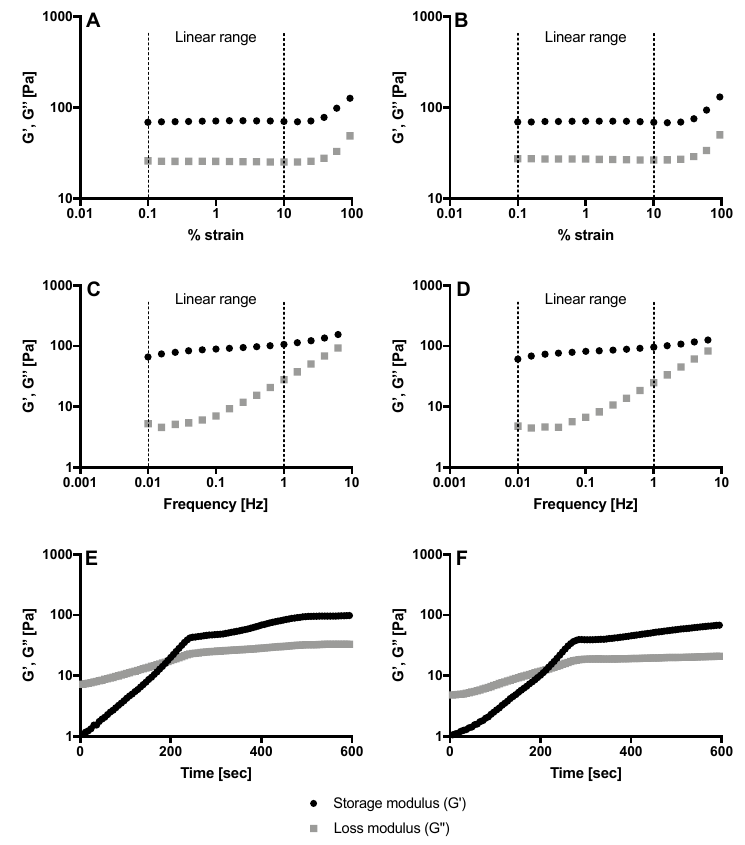
Figure 1. Rheological characterization of the synthesized methylcellulose hydrogels. ( A , B ) Strain sweep for 10% ( w / v ) methylcellulose hydrogel with 1% ( v / v ) Melissa o ffi cinalis ( A ) and 2% ( v / v ) Melissa o ffi cinalis ( B ). ( C , D ) Frequency sweep for 10% ( w / v ) methylcellulose hydrogel with 1% ( v / v ) Melissa o ffi cinalis ( C ) and 2% ( v / v ) Melissa o ffi cinalis ( D ). ( E , F ) Time sweep for 10% ( w / v ) methylcellulose hydrogel with 1% ( v / v ) Melissa o ffi cinalis ( E ) and 2% ( v / v ) Melissa o ffi cinalis ( F ) determined at an amplitude strain of 1% and angular frequency of 1 Hz. G (cid:48) (black circle) storage modulus and G” (grey square) loss